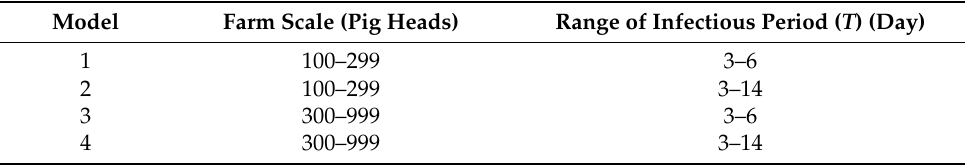
Table 1. Modeling scenarios for the within-farm transmission of ASFV.